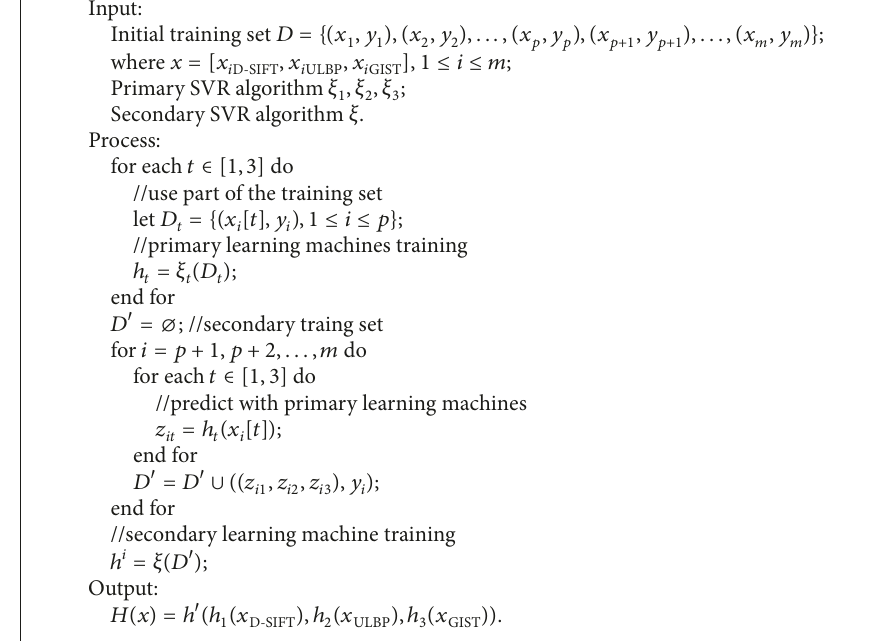
Algorithm 1: The learning based combination strategy.